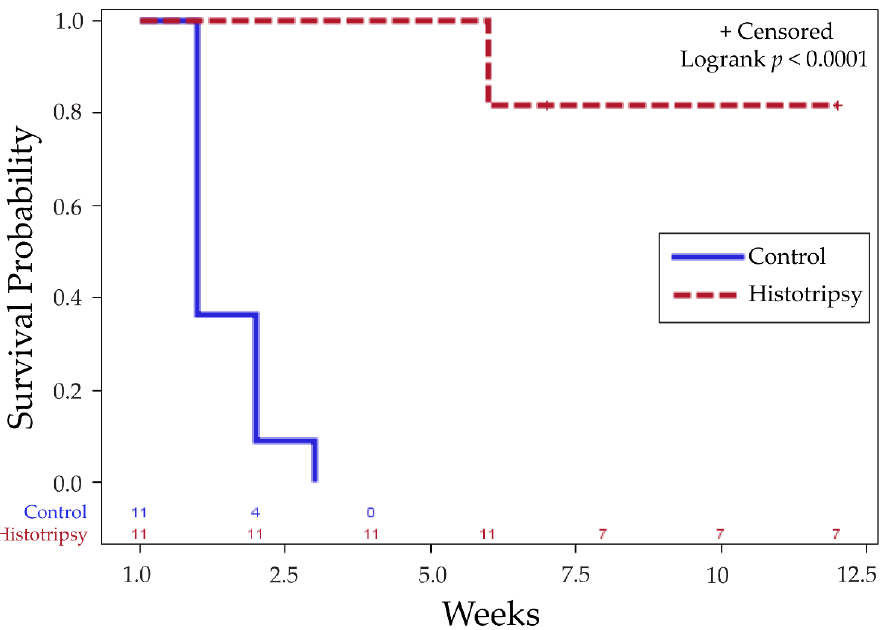
Figure 2. Kaplan–Meier survival curve indicates significant difference in survival outcomes of histotripsy-treated animals vs. untreated controls for tumor progression ( p < 0.0001). ‘+ Censored’ indicates that observations are right censored as n = 2/11 histotripsy animals still surviving at 7 weeks with no observable tumor were euthanized due to COVID shutdown.